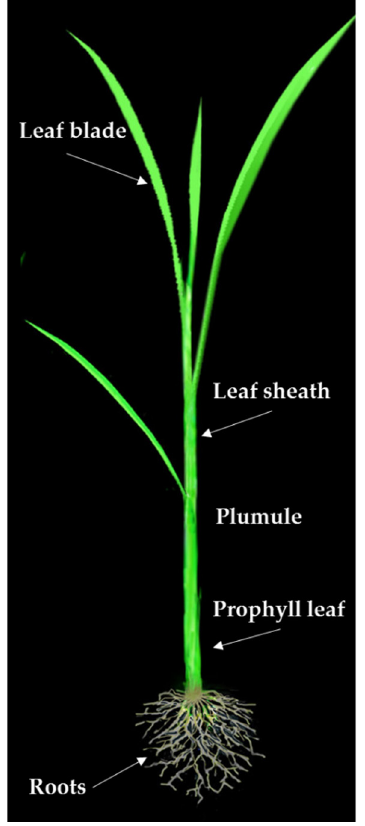
Figure 1. Morphology of a rice seedling.